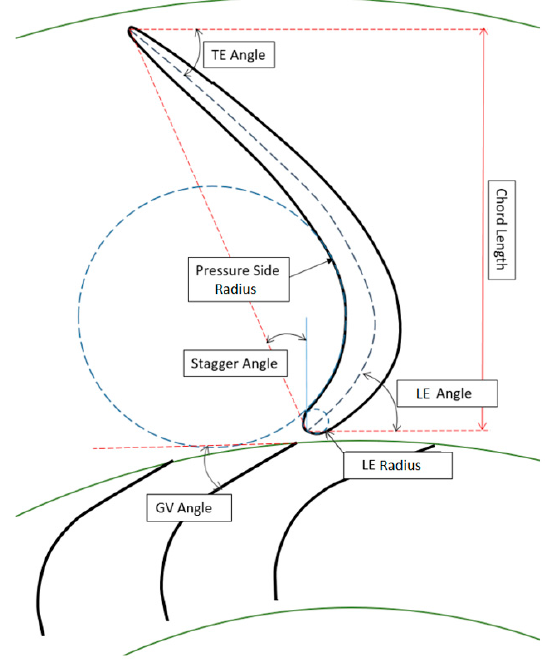
Figure 2. Illustration of the parameters used in creation of the blade profile.